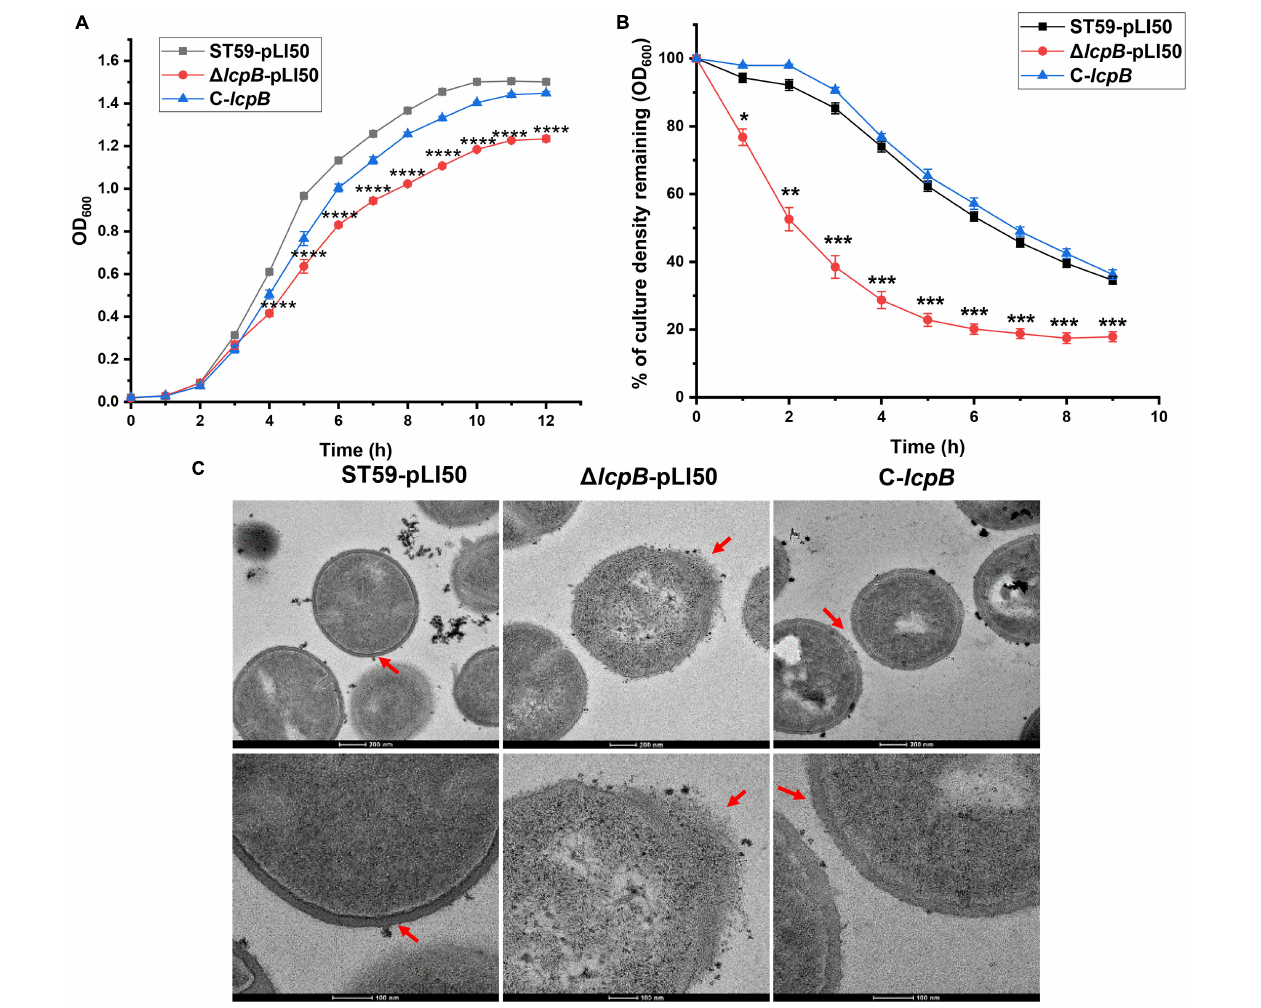
FIGURE 1 | Deficiency of lcpB causes an abnormal cell wall morphology. (A) Growth of the wild-type, lcpB mutant, and lcpB complemented strains. The results were obtained from three independent experiments performed in triplicates. Data is presented as the mean ± SD or SEM. Two-tailed Student’s t -test is used for the comparison of statistical significance. The wild-type strain was used as the reference. * p < 0.05; ** p < 0.01; *** p < 0.001, **** p < 0.0001. (B) Analysis of the autolysis rate. The rate of autolysis in the wild-type, lcpB mutant, and complemented strains was determined at 37 ◦ C using Tris-HCl buffer containing 0.05% Triton X-100. Changes in optical density were then measured upon exposure to the detergent. The results were obtained from three independent experiments performed in triplicates. Data is presented as the mean ± SD or SEM. Two-tailed Student’s t -test is used for the comparison of statistical significance. The wild-type strain was used as the reference. * p < 0.05; ** p < 0.01; *** p < 0.001. (C) Transmission electron microscopy was performed to evaluate cell wall morphology. These results were obtained from three independent experiments performed in